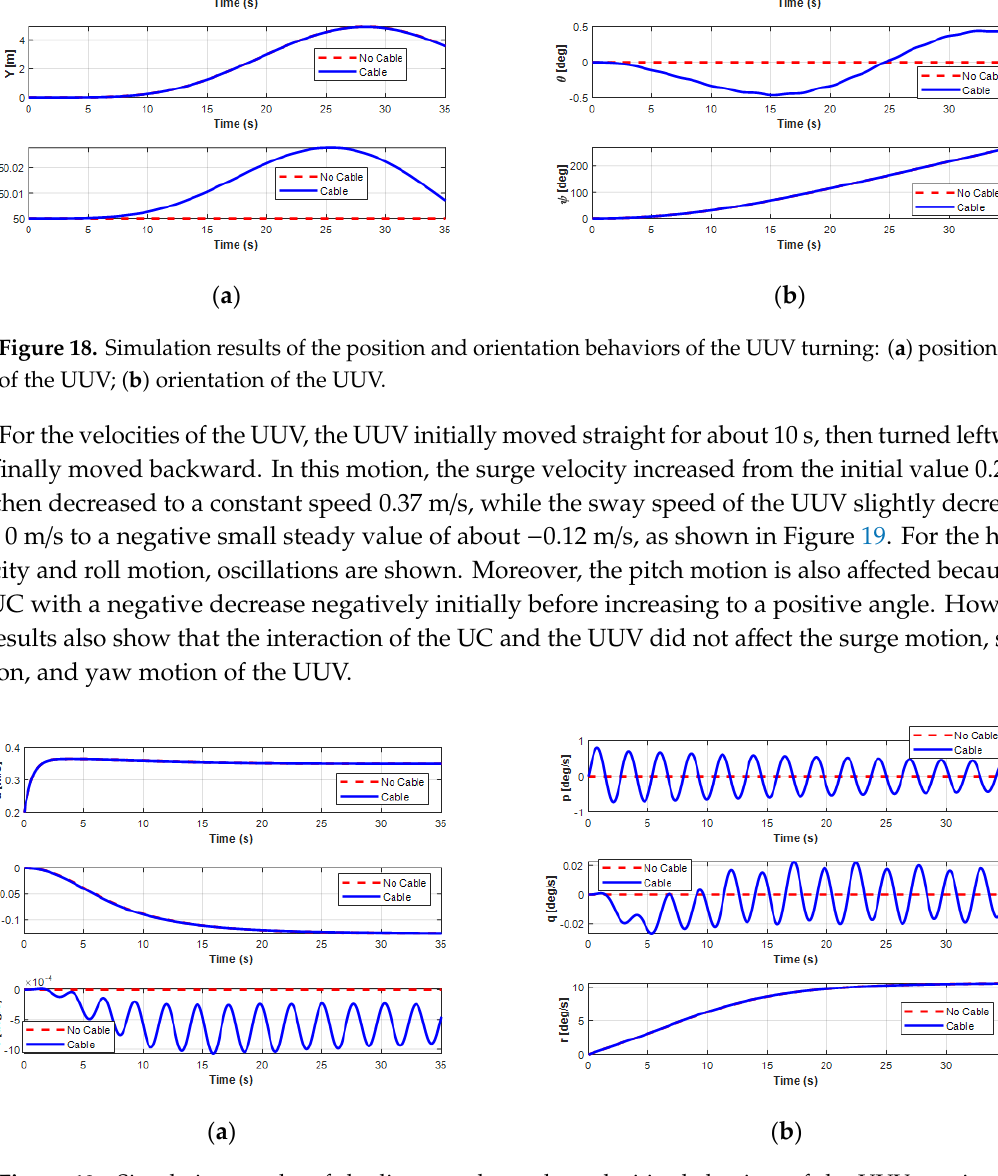
Figure 19. Simulation results of the linear and angular velocities behaviors of the UUV turning: ( a ) linear velocities of the UUV; ( b ) angular velocities of the UUV.